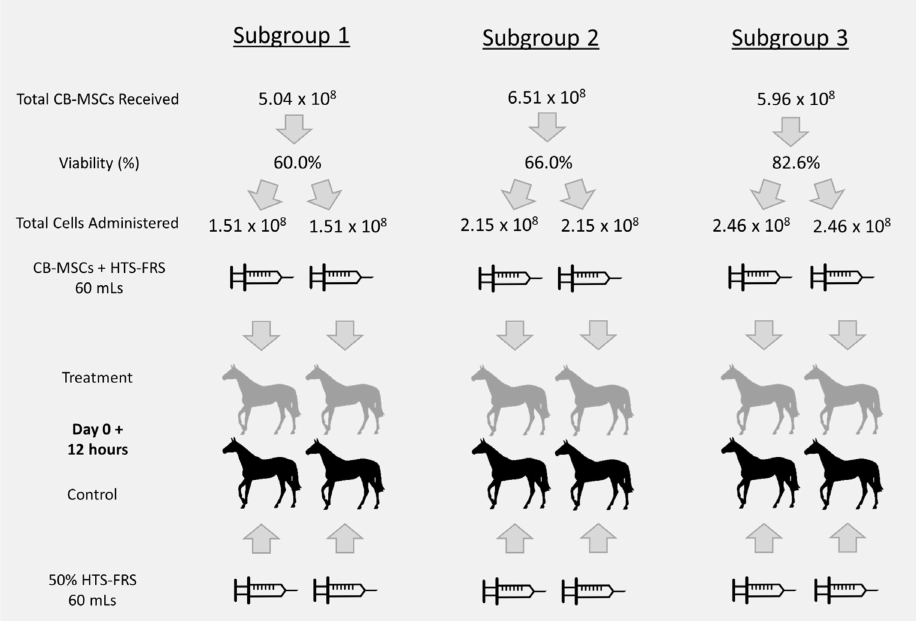
Figure 1. Basic schematic of division of horses into treatment and control subgroups and total number of allo-CB-MSCs administered. Twelve horses were randomly placed into a treatment and control group and then further divided into three subgroups. Following shipment of cells, a total cell count and assessment for viability were performed. The total cells were evenly divided, suspended in 50% diluted HypoThermosol FRS (HTS-FRS), and administered IV to the treatment horses. The control horses were administered a placebo IV injection of 50% diluted